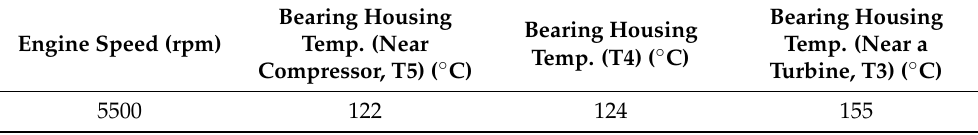
Table 4. Bearing housing temperature at full load condition.